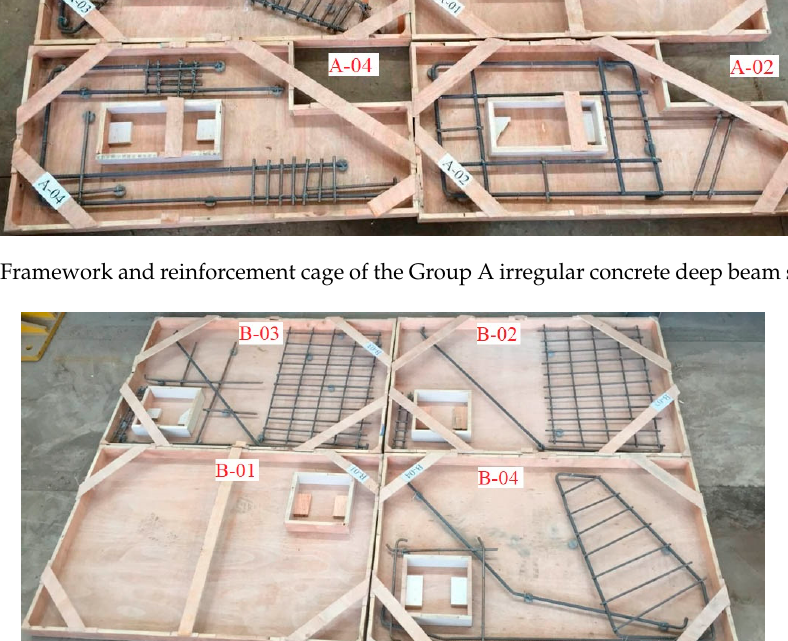
Figure 13. Framework and reinforcement cage of the Group B irregular concrete deep beam specimens.